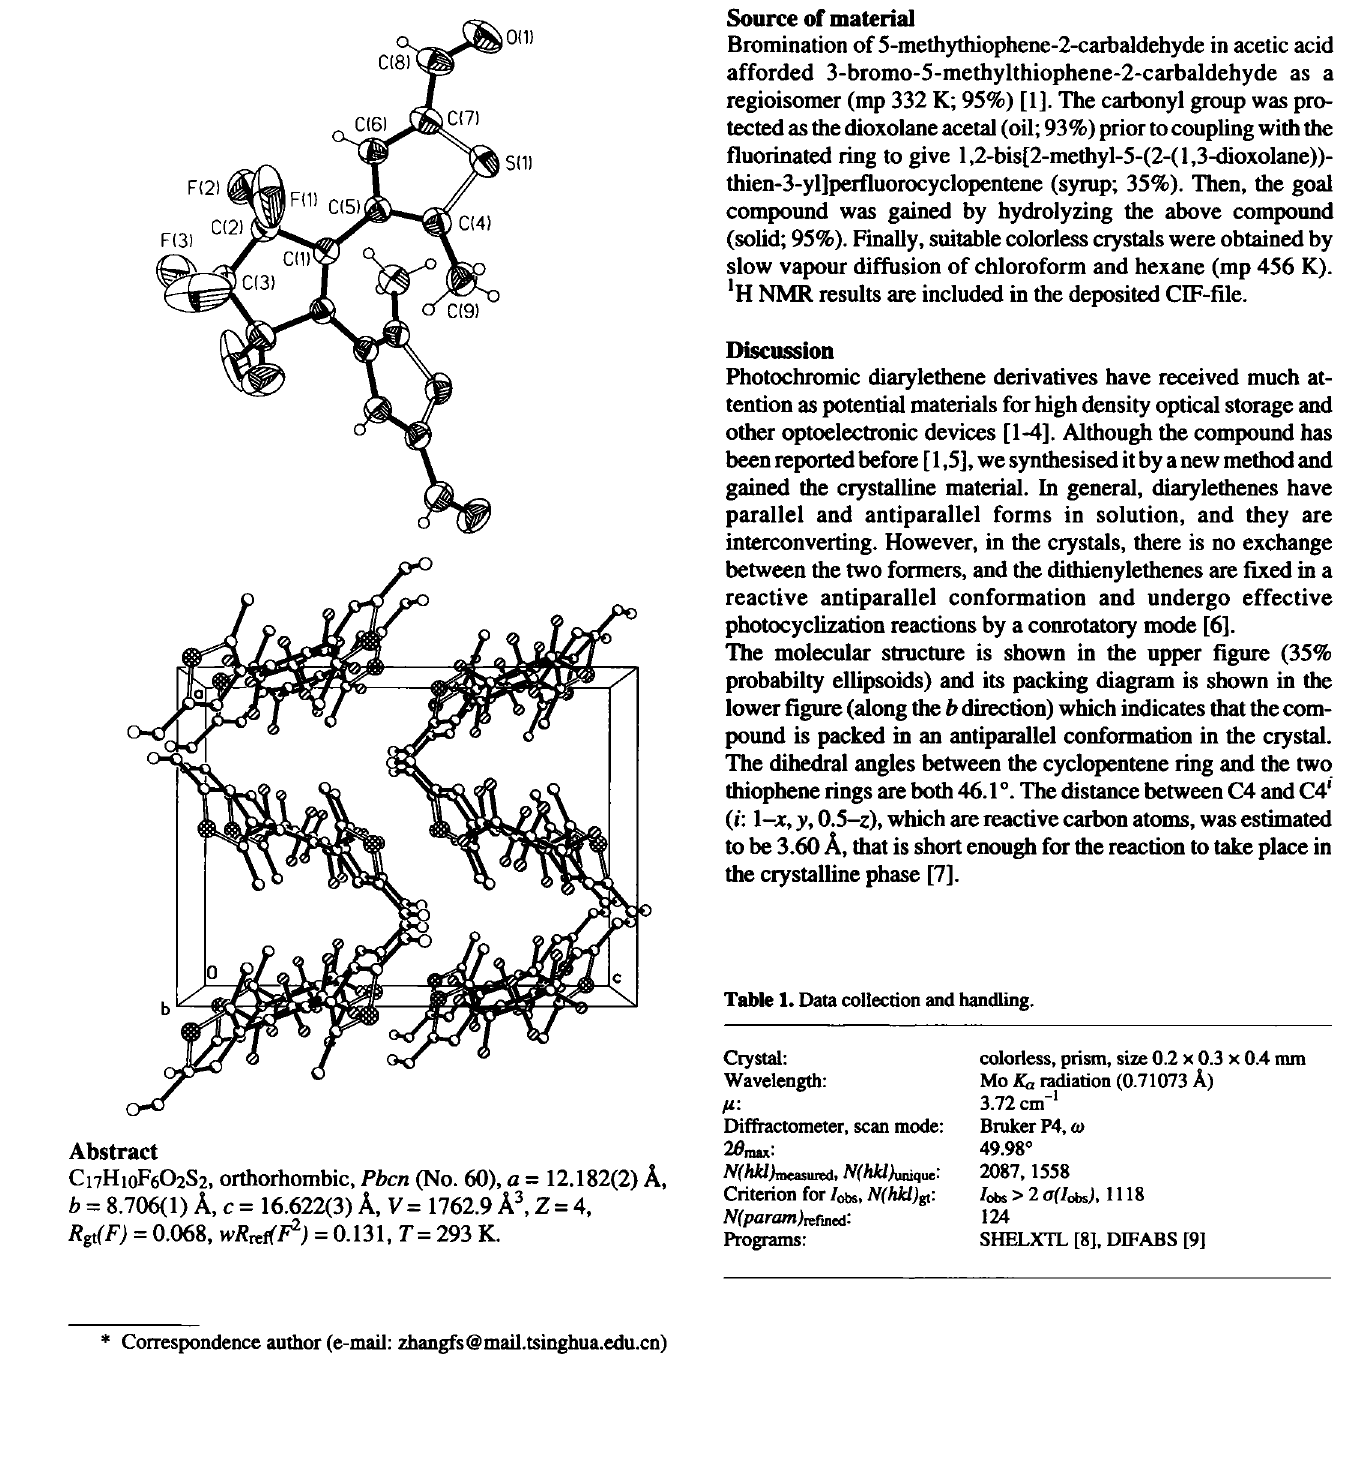
Table 1. Data collection and